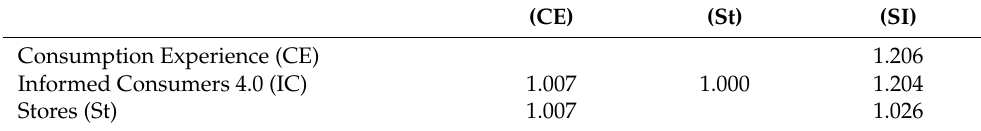
Table 8. Structural model—Multicollinearity check (Variance Inflated